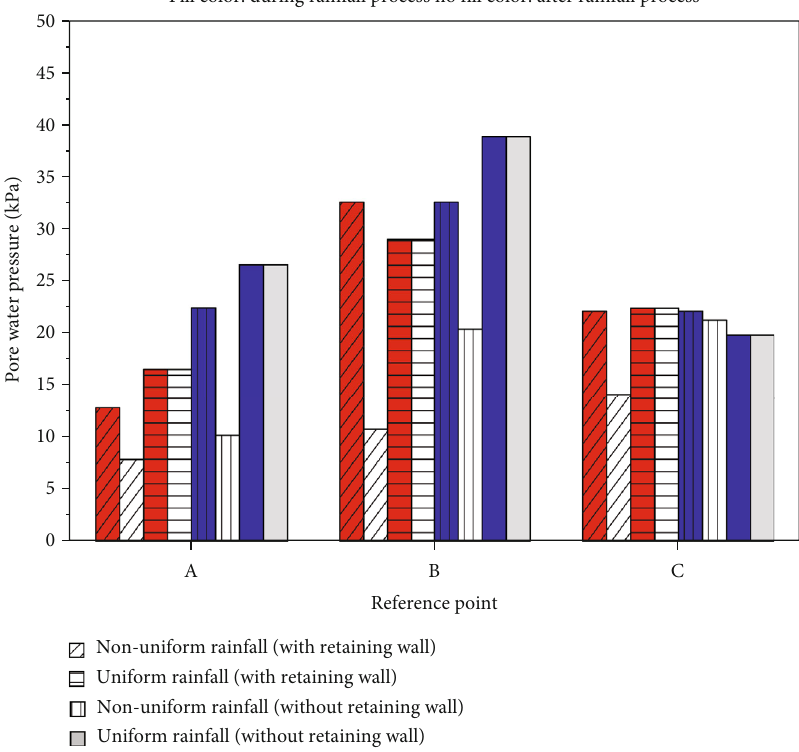
Figure 12: The pore water pressure of the slope reference points with retaining wall under rainfall.